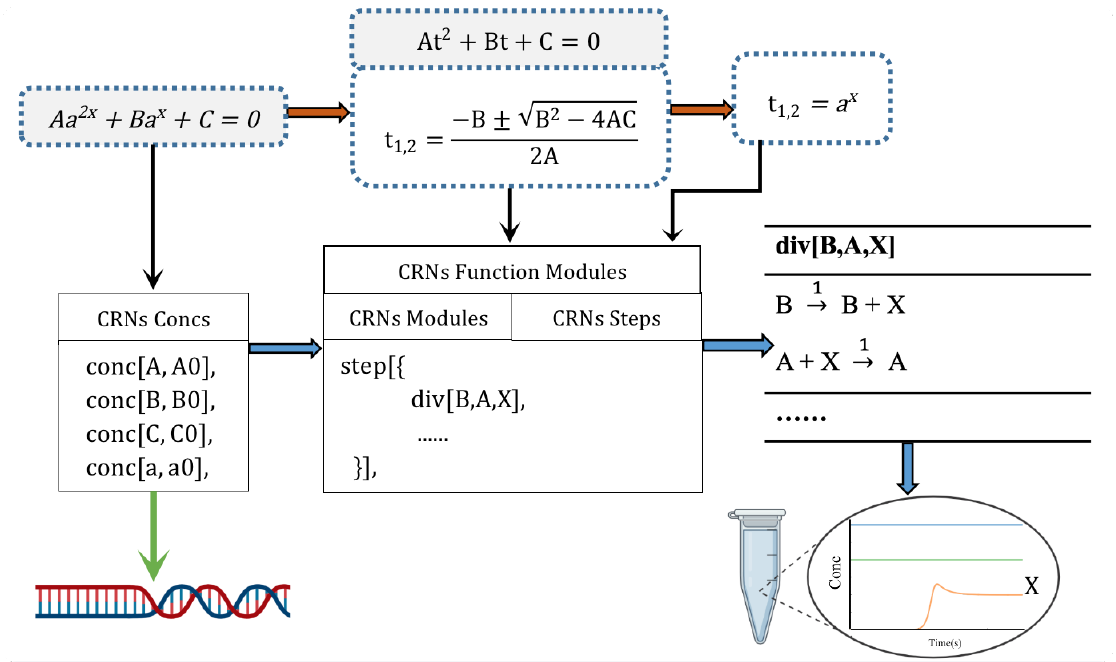
Figure 1. The basic design framework principle. The solid red line represents the mathematical steps of solving the equation, and the solid black line represents the mapping in the design of the CRNs. The solid blue line represents the process of the CRNs compiled, and the solid green line represents the corresponding molecular substrate in the CRNs. The gray background does not require construction steps, so only the parameters are